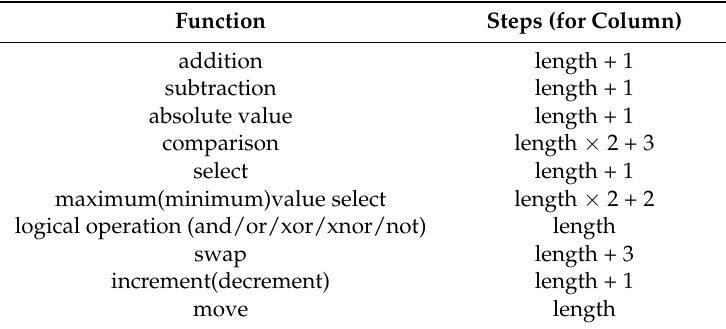
Table 1. Steps for calculation.